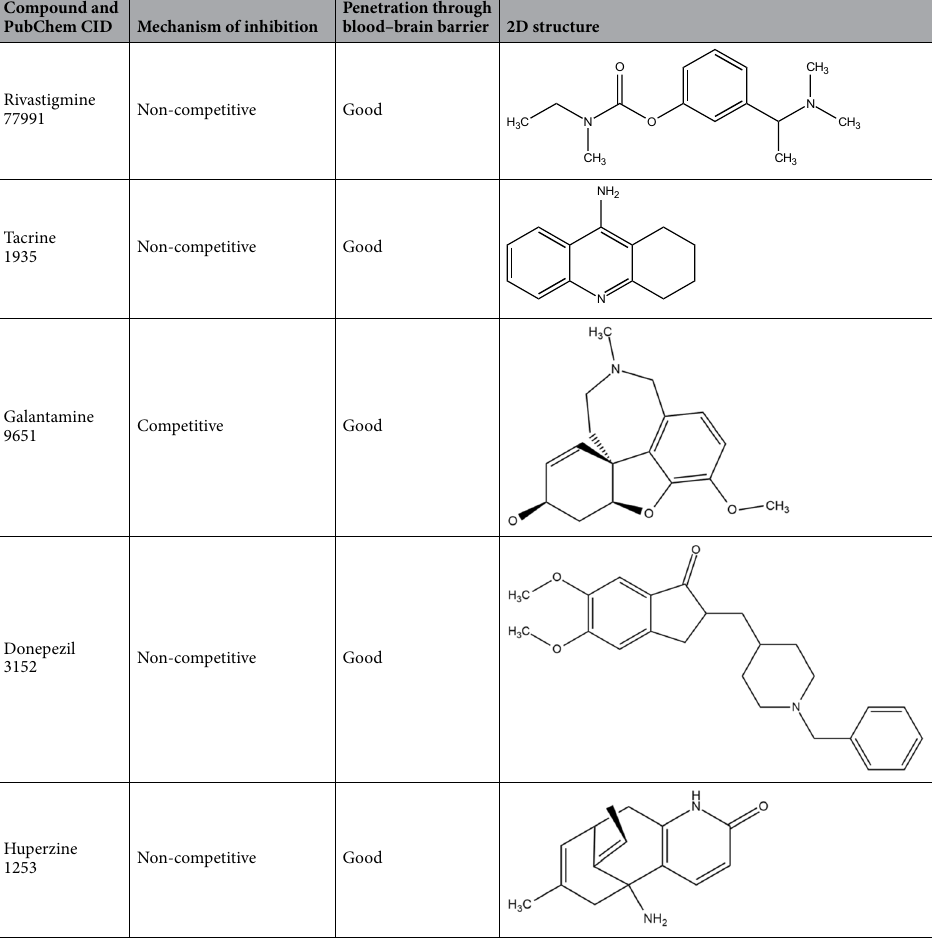
Table 1. Characteristics and properties of approved cholinesterase inhibitors.